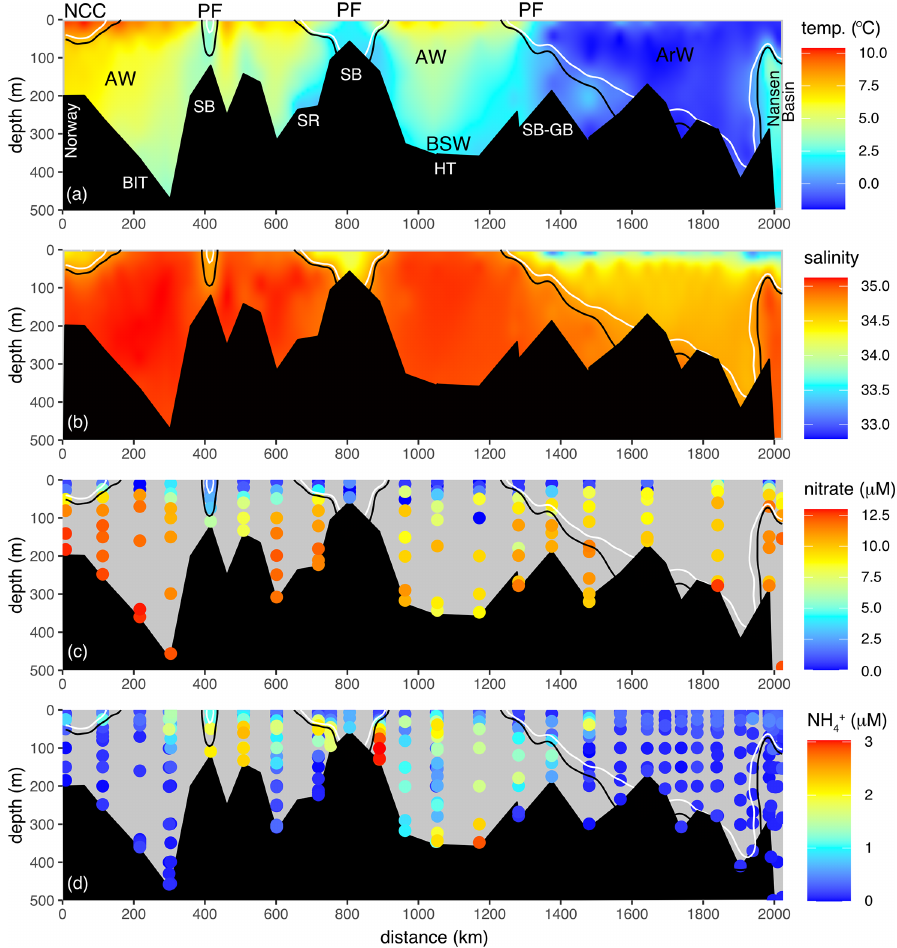
Figure 2. Full 2017 transect of (a) temperature, (b) salinity, (c) nitrate and (d) NH + . Transect is displayed in Fig. 1. Solid black and white 4 lines are the 34.8 and 34.7 isohalines. Atlantic Water (AW), Arctic Water (ArW), Barents Sea Water (BSW) and the Norwegian Coastal Current (NCC) are indicated in (a) . For reference, key bathymetry features are marked in (a) : Spitsbergen Bank (SB), Storfjordrenna (SR), Hopen Trench (HT), Bear Island Trough (BIT), and the Spitsbergen and Great banks sill (SB-GB). PF marks the location of the surface expression of the polar